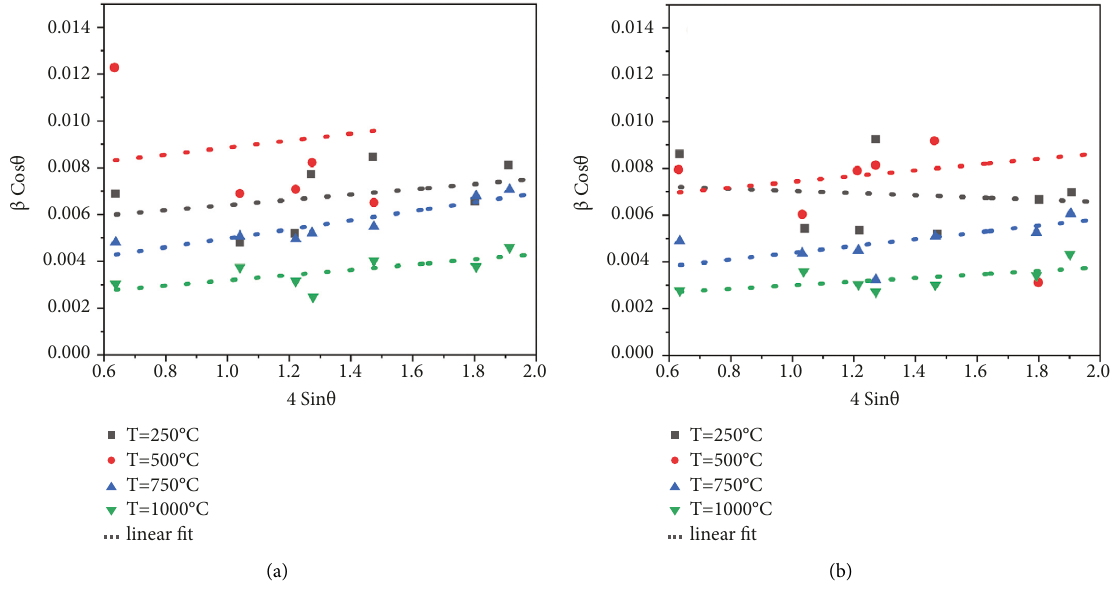
Figure 4: W–H plot for Ni 1-x Zn x Fe 2 O 4 ferrites at different annealing temperatures of (a) x